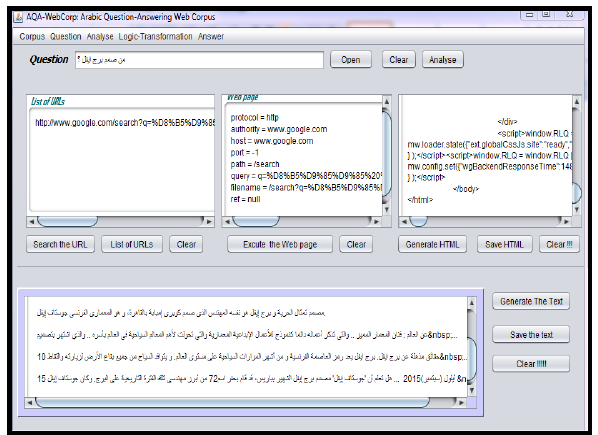
Figure 8. Example of a text containing an answer to the following question:: "